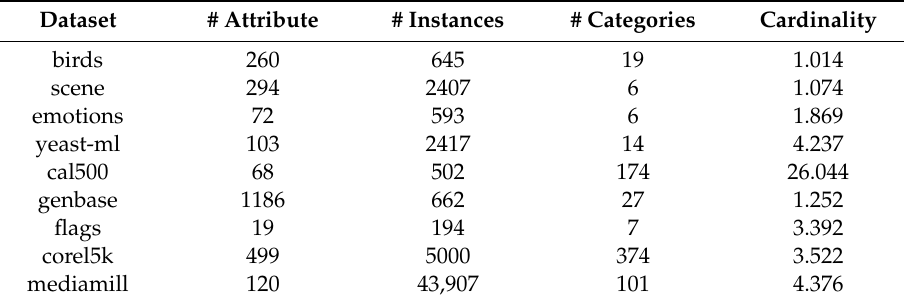
Table 3. Characteristics of the datasets for multi-label multi-class classification.